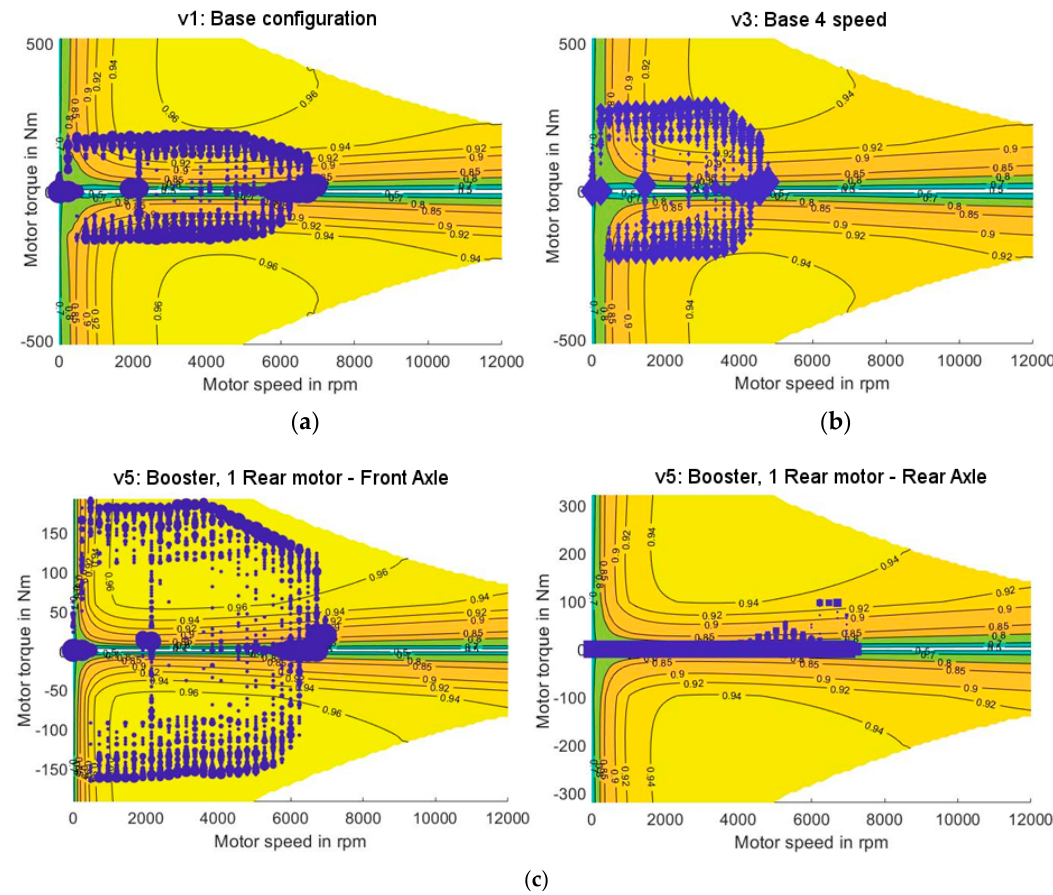
Figure 12. Load point shifting by transmission ( a ) v1 configuration with fixed gear ( b ) 4 speed configuration ( c ) v5 Booster configuration.